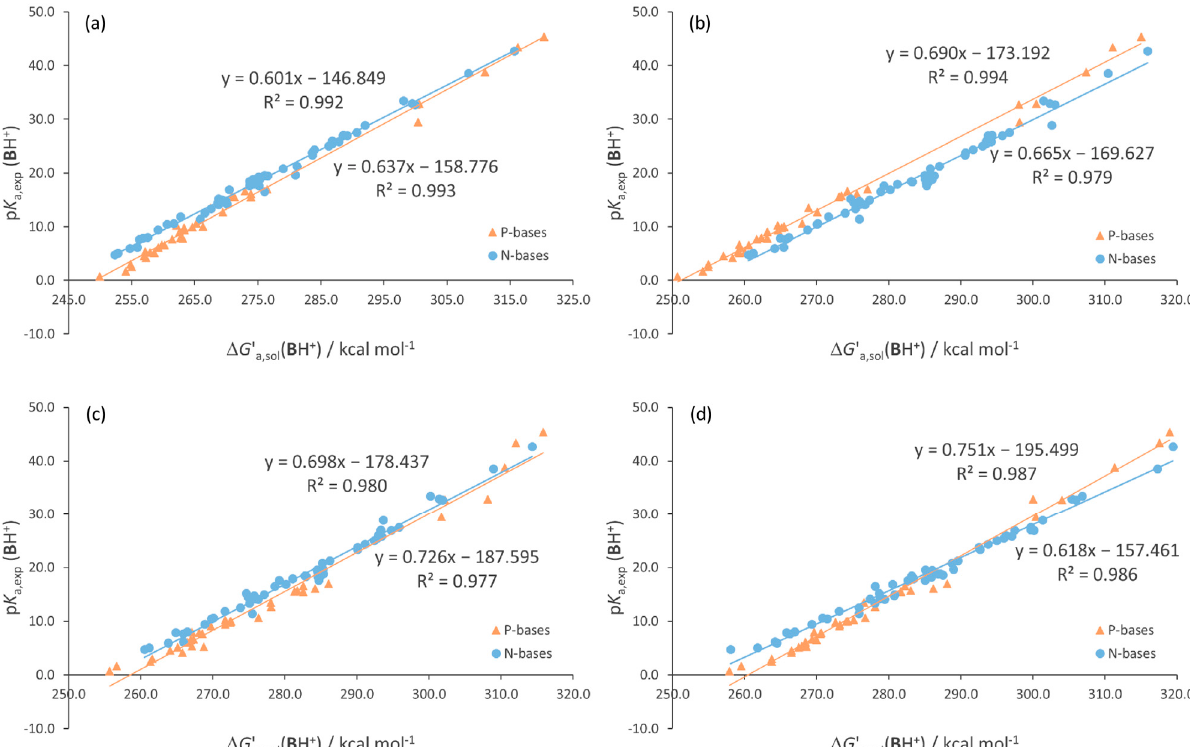
Figure 2. Correlation of experimental p K a against ∆ G ’ a,sol for N and P bases calculated at the ( a ) IPCM//M6, ( b ) CPCM//M6, ( c ) SMD1//M6, and ( d ) SMD2//M3 levels of theory.